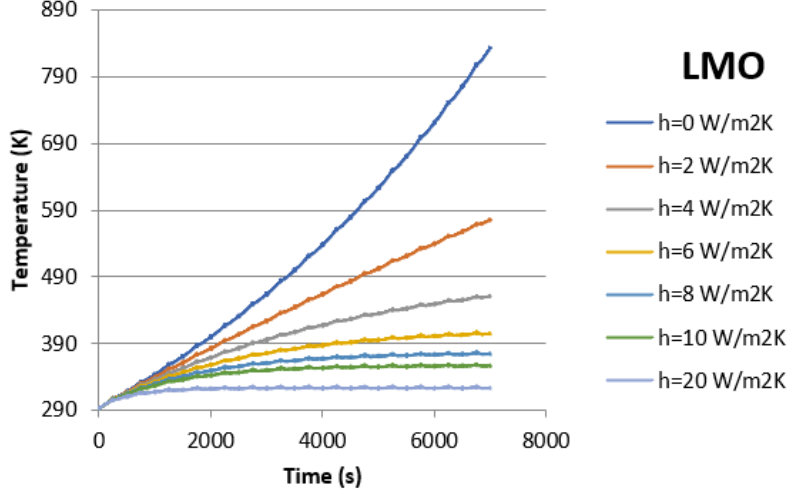
Figure 5. Temperature profile for an LMO cell in the absence of exothermic reactions.